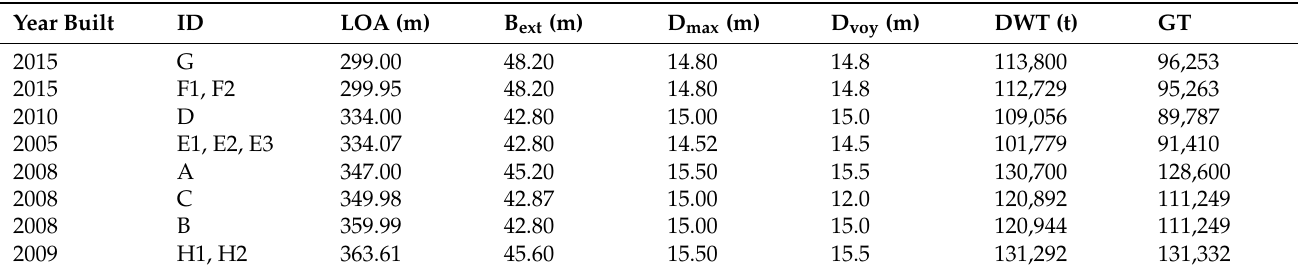
Table 1. Container ship fleet